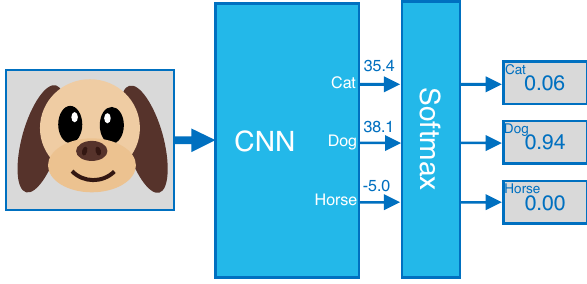
Figure 1. Example of a three classes CNN: Cats, Dogs, and